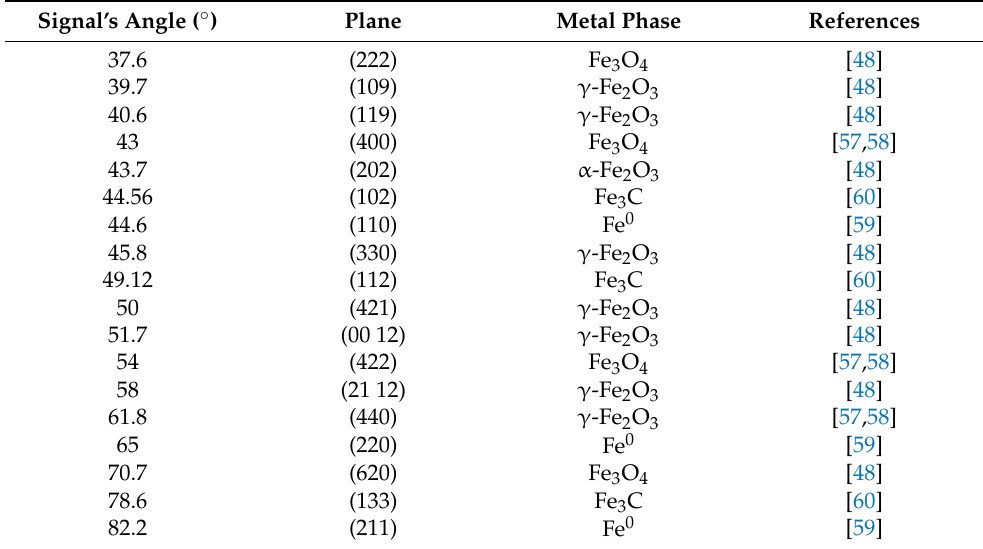
Table A3. XRD plane identification in spent